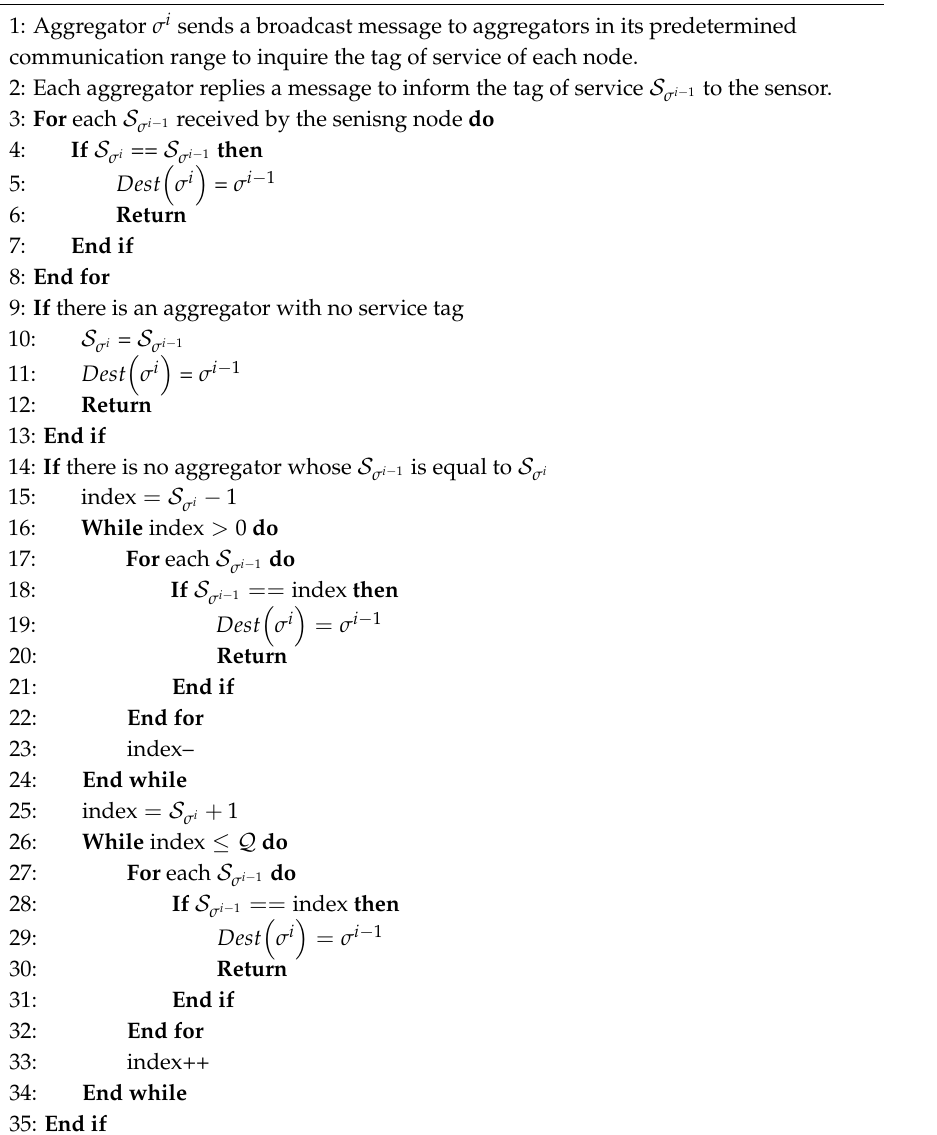
Algorithm 3 Establishment of Routing for an Aggregator in Level i σ i